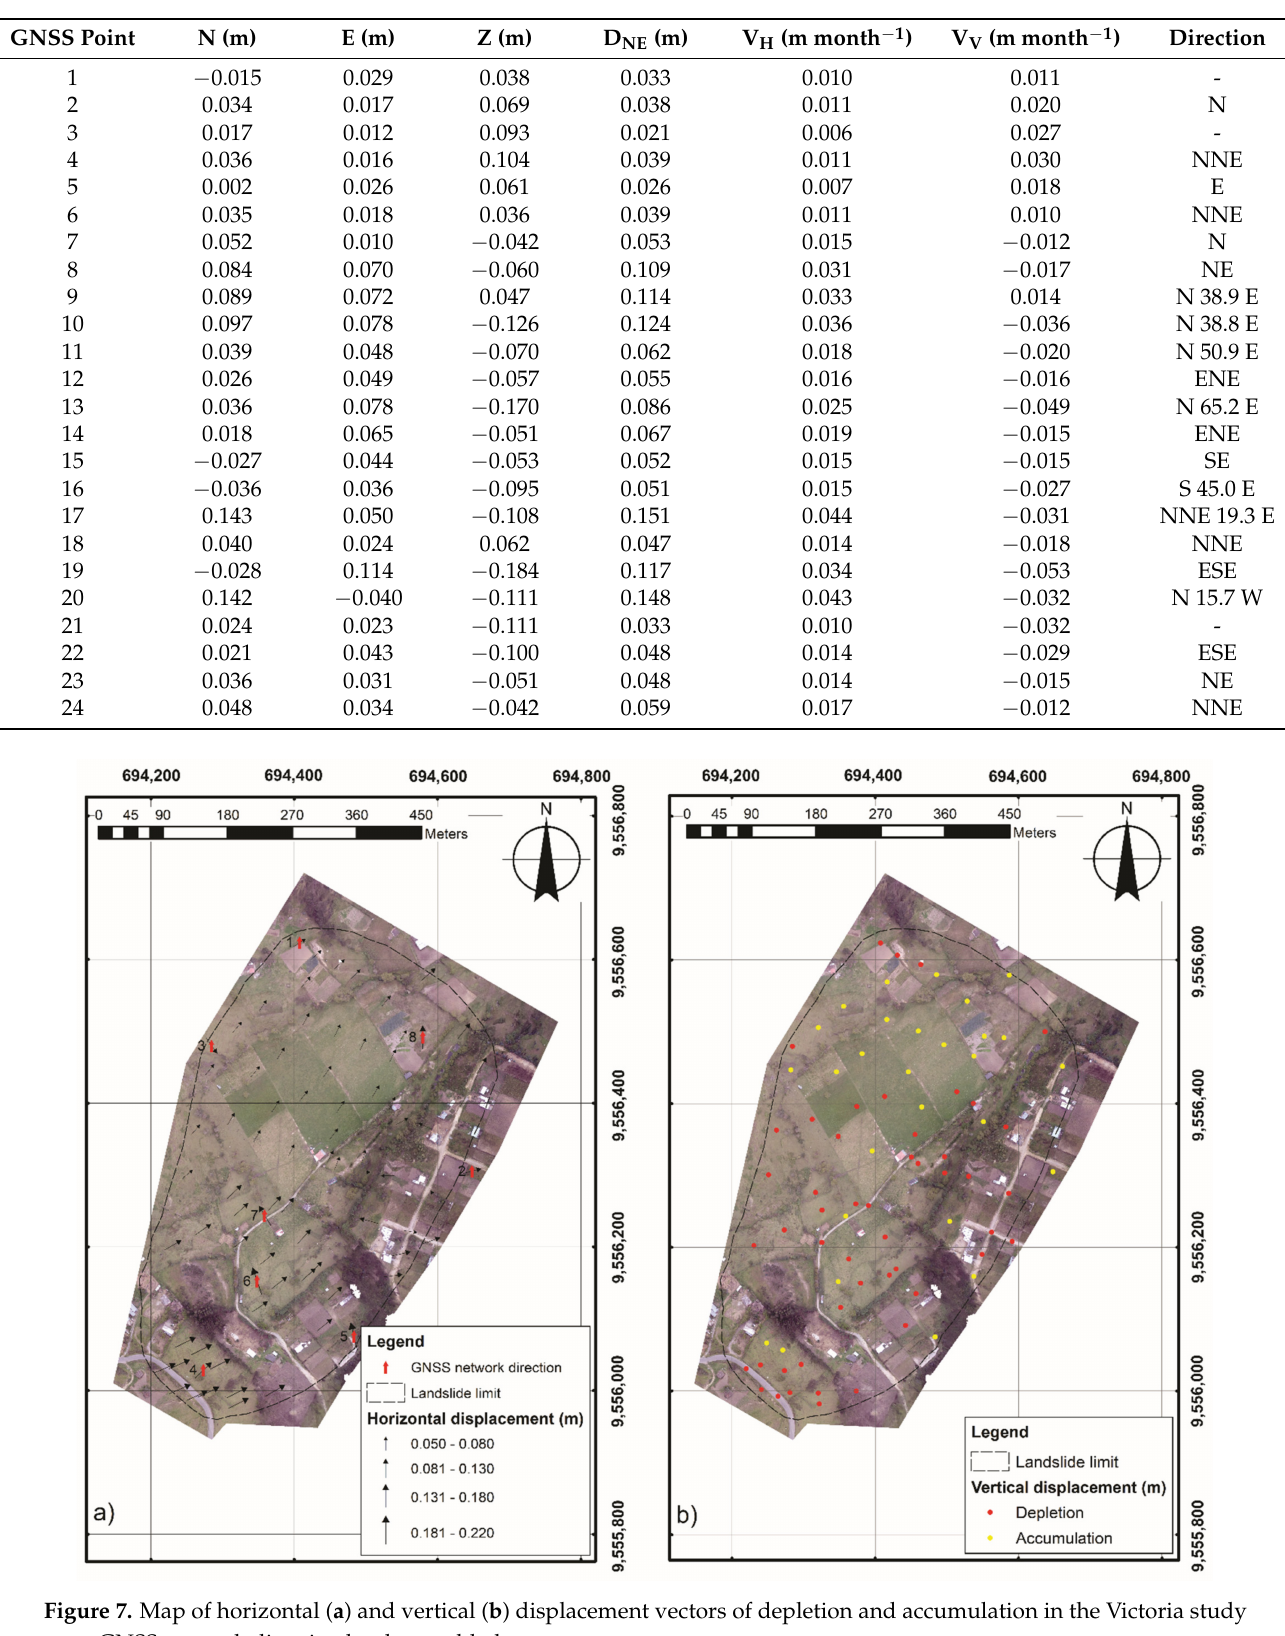
Figure 7. Map of horizontal ( a ) and vertical ( b ) displacement vectors of depletion and accumulation in the Victoria study area. GNSS network direction has been